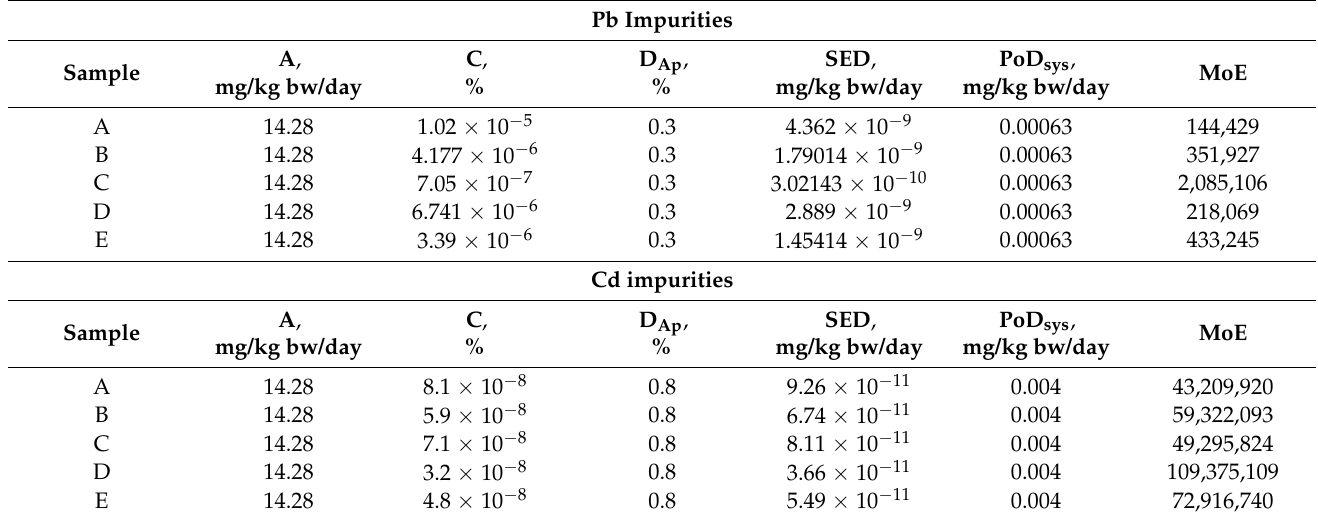
Table 6. Summary of the safety assessment (SED and MoE) for impurities of Pb and Cd in ointments with marjoram herb extract ( Majoranae herbae extractum ) via the dermal